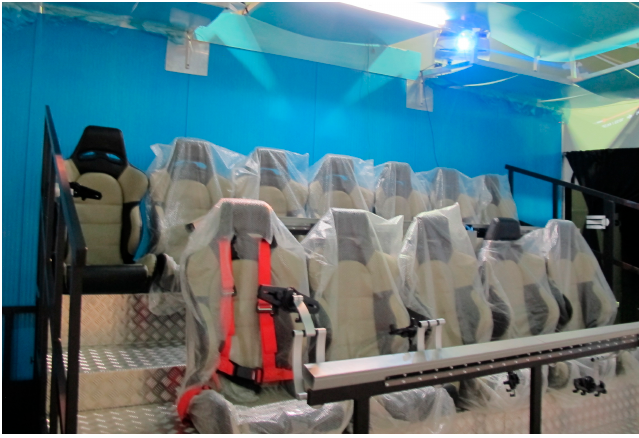
Figure 1. Image of the robotized house.